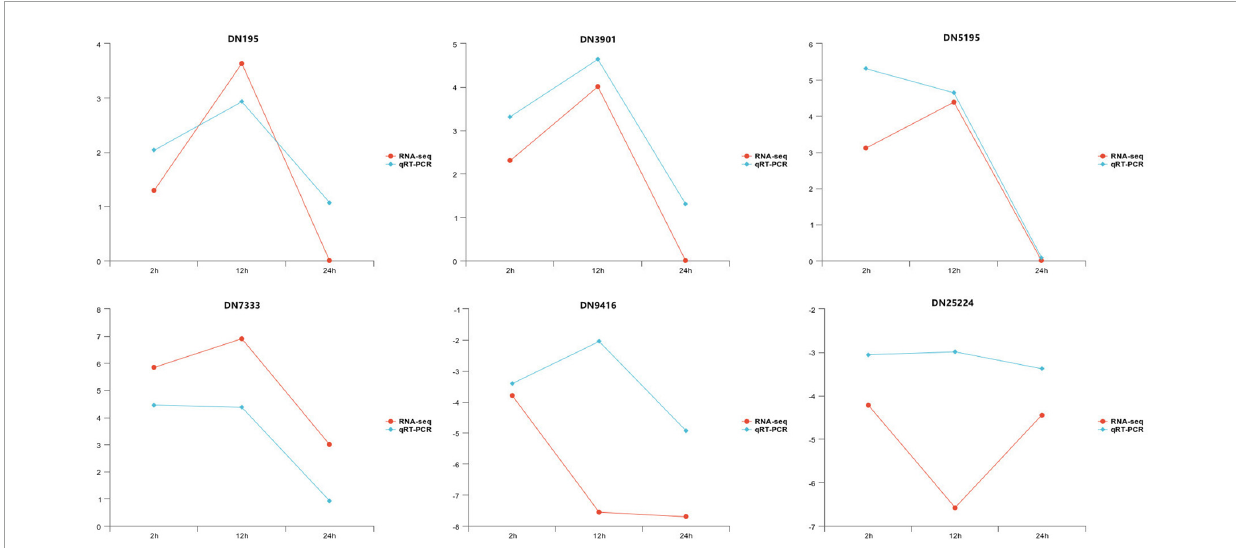
FIGURE5 Differentially expressed genes (DEGs) comparison between two samples (CK vs. GT2, CK vs. GT12, and CK vs. GT24) mapped to the sphingolipid metabolism (map00600; red for up-regulated, green for down-regulated).